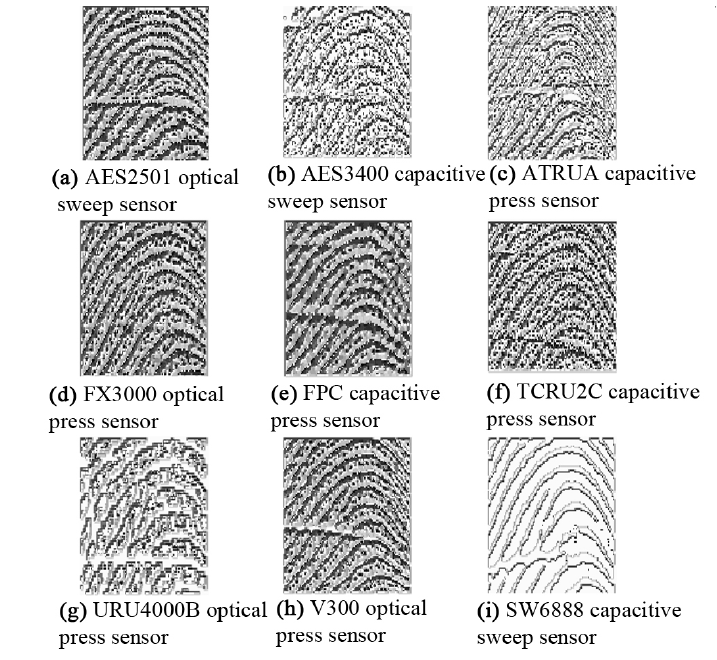
Figure 2. Corresponding local binary patterns (LBPs) for the fingerprints in Figure